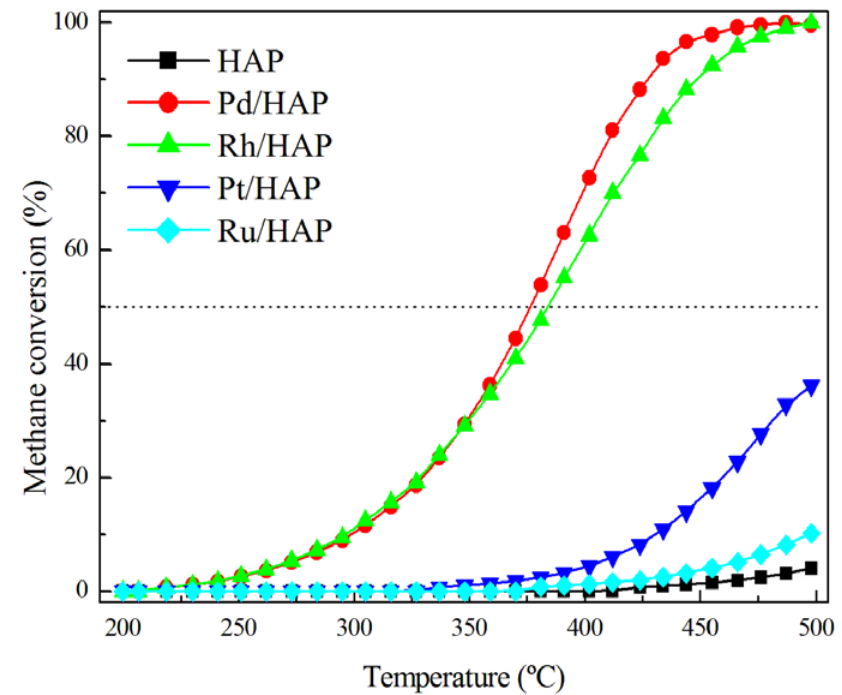
Figure 6. Comparison of the performance of the prepared catalysts in the methane oxidation. The reaction mixture was composed of 1% CH 4 , 20% O 2 , and 79% He.